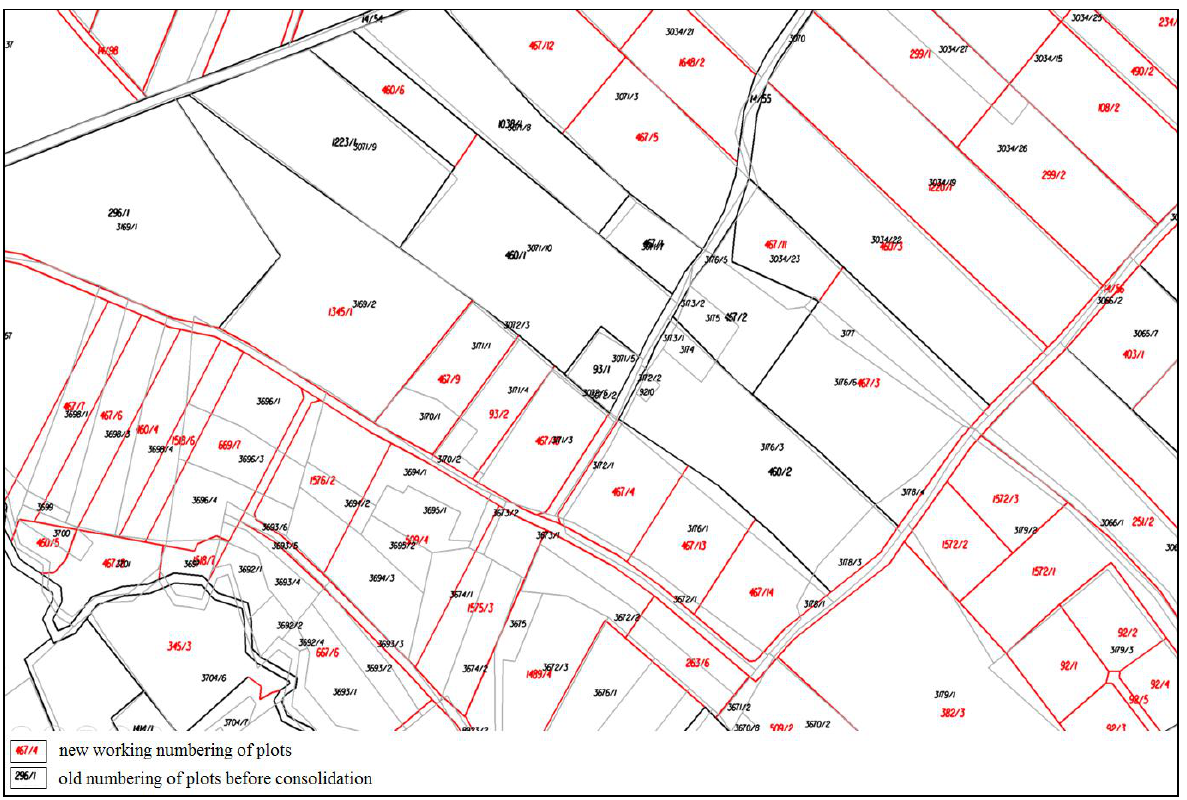
Fig. 4. Situation after consolidation – legal access to the public road system (source: own